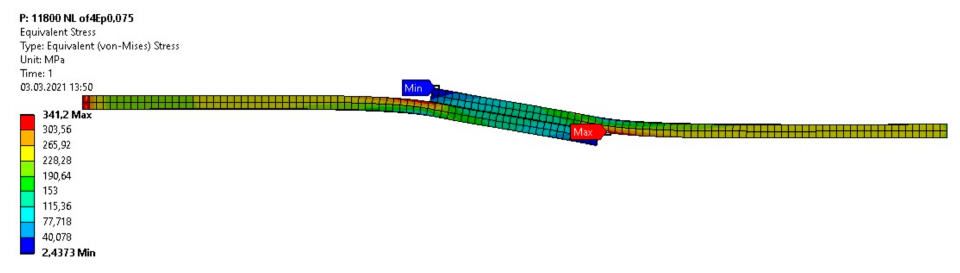
Figure 9. Deformation of a single lap specimen under shear load with a force of 11,800 N (scale 3.2:1, plastic deformation of jointed elements) and Mises stress distribution.